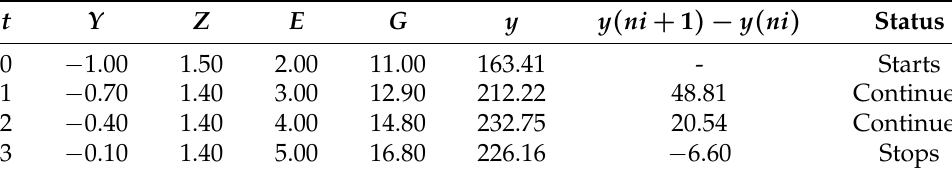
Table 8. Results for the MKSR procedure in Case 2.